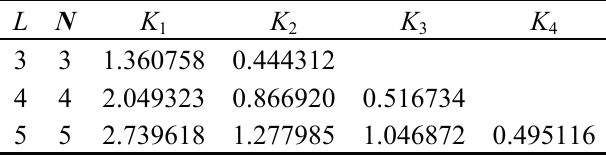
Table 2. LMSc algorithm coefficients.